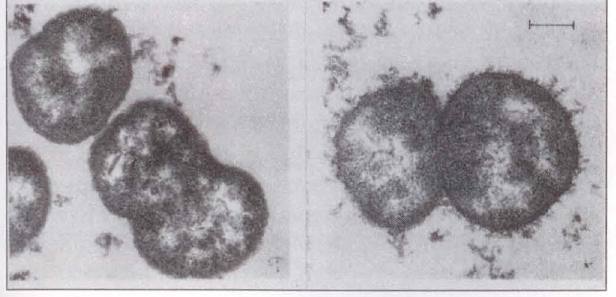
Figure 5) View of gonococci under the electron microscope. After staining the control and cytidine 5'-monophospho·N·acetyl· neuraminic acid (CMP-NANA}-treated organisms with ruthenium red. the structure formed under the influence of CMP-NANA is very reminiscent of the capsular structure that has been described